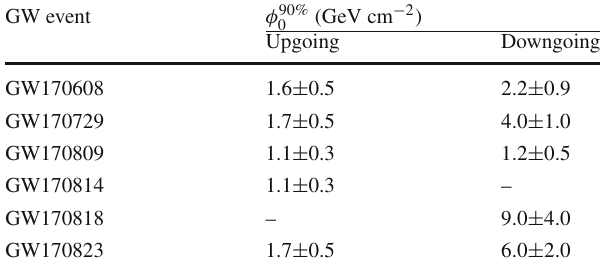
Table 2 Average fluence upper limit inside the 90% CL